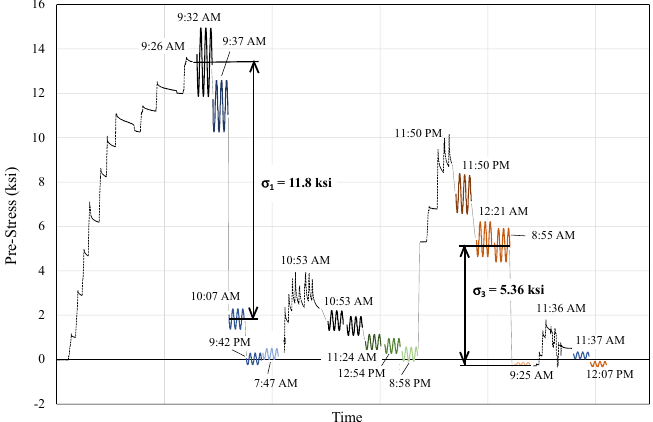
Figure 36. Measured CFRP pre-stress during rapid cyclic loading.